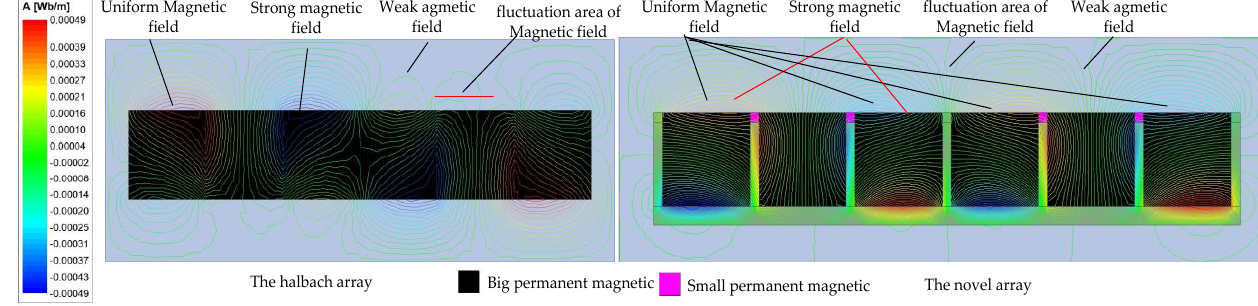
Figure 8. Magnetic circuit of the two schemes.